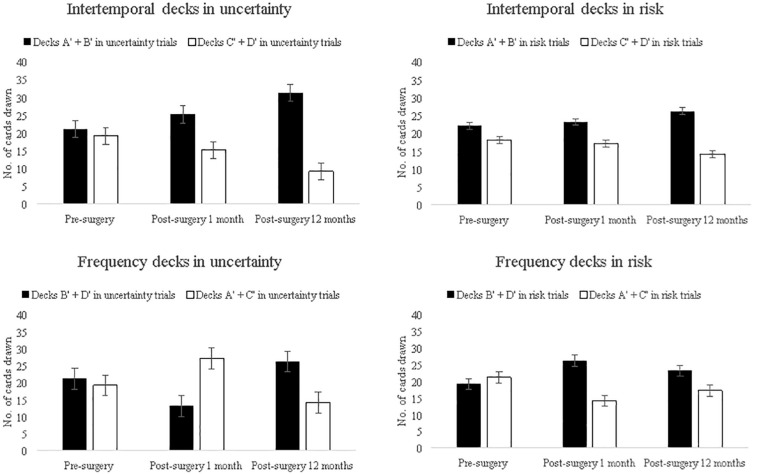
Number of cards drawn from long-term risky decks (A′ + B′) and safe decks (C′ + D′) during uncertainty (top left-hand corner) and risk trials (top right-hand corner) before and after surgery, and number of cards drawn from infrequent punishment decks (B′ + D′) and frequent punishment decks (A′ + C′) during uncertainty (bottom left-hand corner) and risk trials (bottom right-hand corner) before and after surgery. Error bars show the standard error.